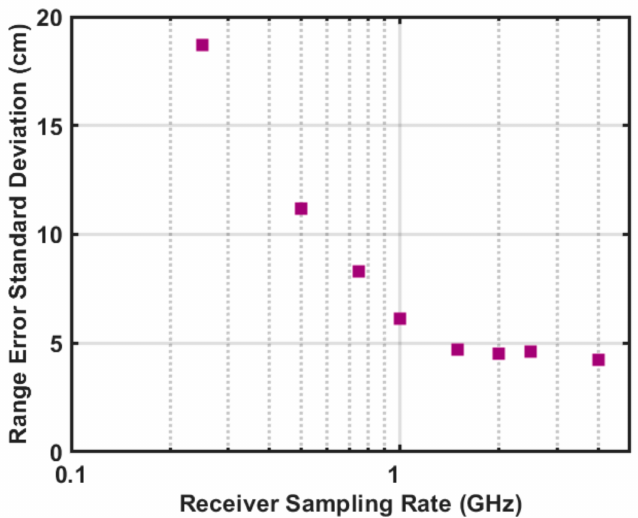
Figure 1. Results of sampling rate test using the PN code performance simulation for the code in Table 1. The range error standard deviation was computed from a population of 25 PN ranging trials, each with a 10 msec integration time. The exact range for each trial was random but all were 50 km ± 1